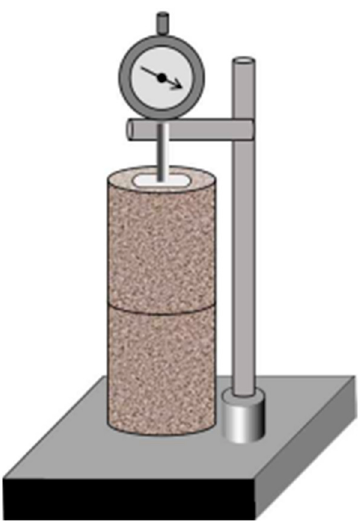
Figure 4. Contraction instrument model.